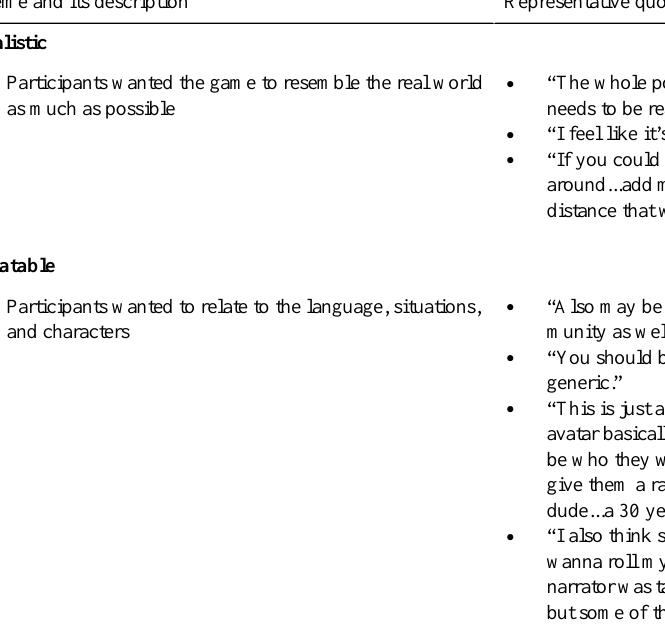
Representative quotesTheme and its